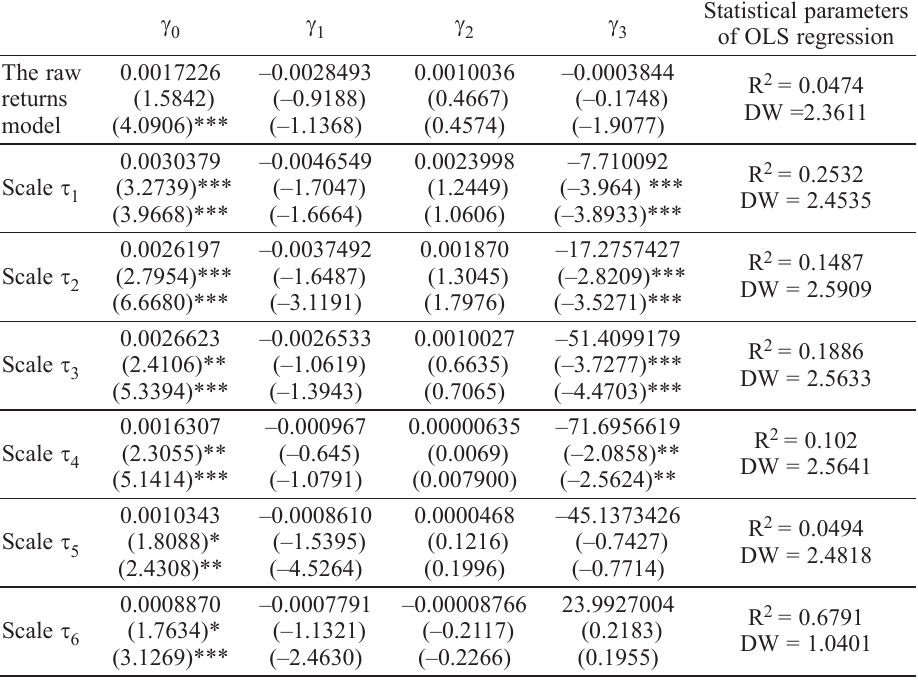
Table 4. OLS and GMM results of testing the CAPM